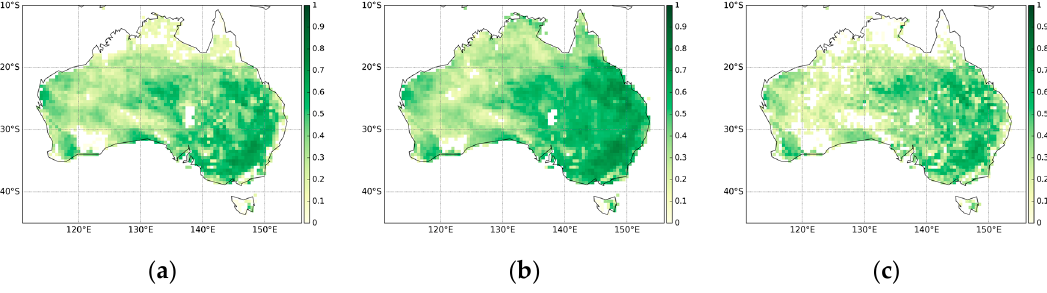
Figure 5. The Pearson correlation coefficient between FAPAR and Standardized Precipitation Evapotranspiration Index (SPEI) during the years 2001–2015: ( a ) MODIS, ( b ) CGLS, ( c ) QA4ECV.